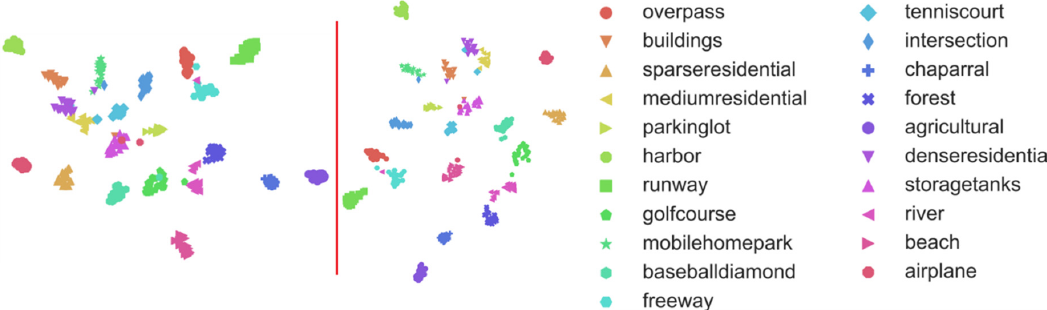
Figure 11. 2-D scatterplots of high-dimensional features generated with t-SNE over the UC Merced dataset. ( left ) without center-loss function. ( right ) with center-loss function.